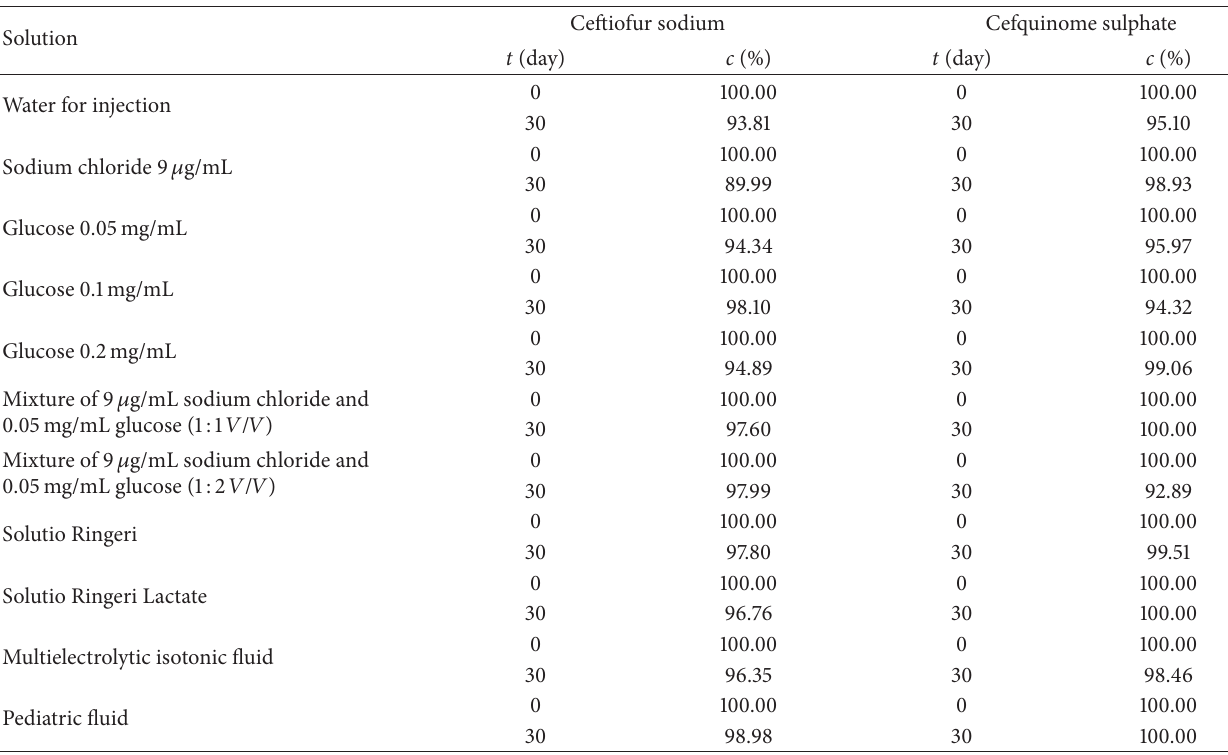
Table 3: Stability of ceftiofur sodium and cefquinome sulphate stored for 30 days at − 20 ∘ C in poly(vinyl chloride) minibags.